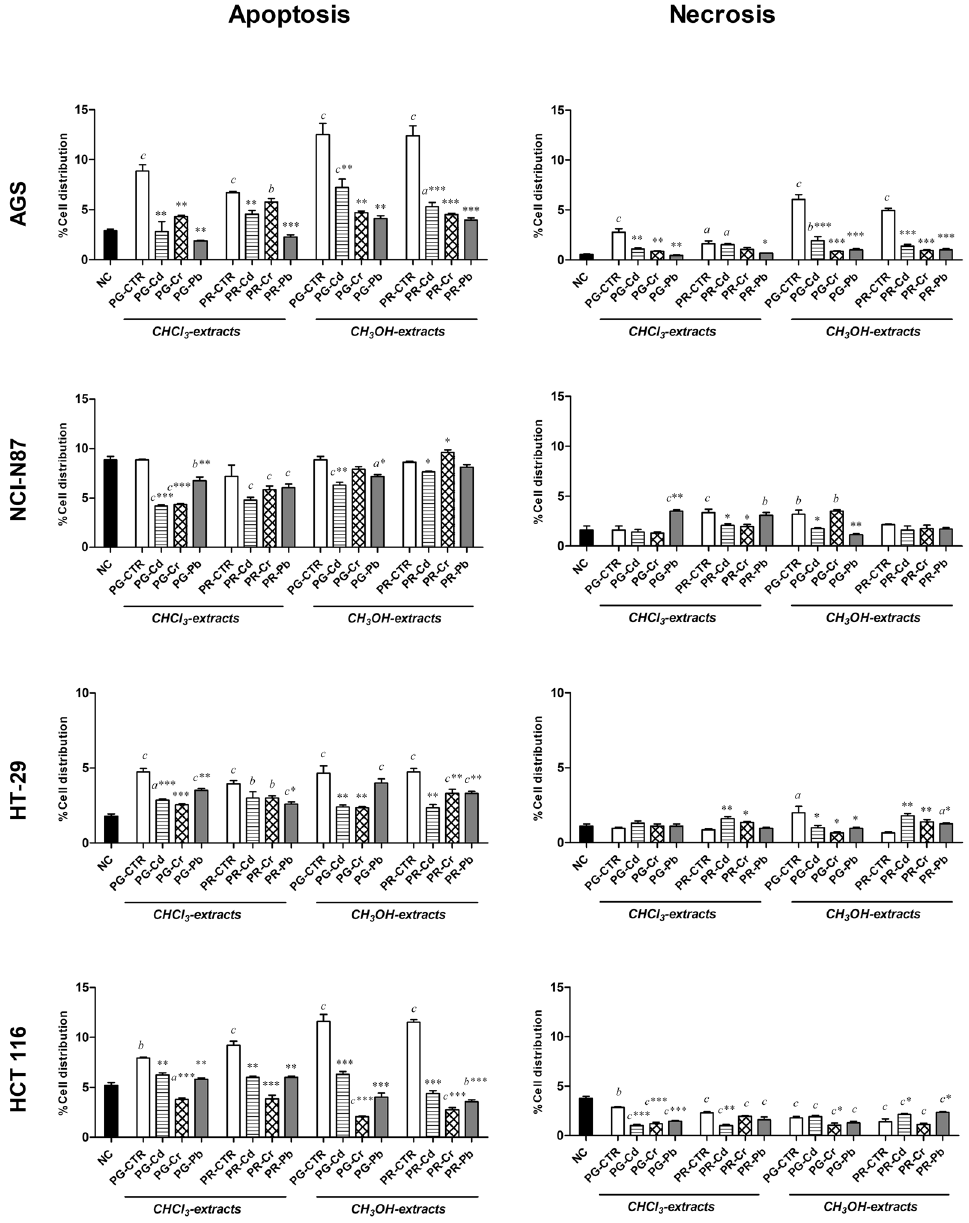
Figure 4. Histograms of apoptotic and necrotic AGS, NCI-N87, HT-29 and HCT 116 cell distribution (in percent) after 72-h treatment. Histograms of apoptotic and necrotic AGS, NCI-N87, HT-29 and HCT 116 cell distribution (in percent) after 72-h treatment with IC50 of chloroform and methanol extracts of Pomodoro Giallo (PG) and San Marzano Cirio 3 (PR) fruits, grown with or without heavy metals (Cd, Cr, Pb) contamination. Results are expressed as means ± SD of three separate experiments. Significant differences from the negative control (NC, untreated cells) are highlighted by letters ( a : p < 0.05; b : p < 0.01; c : p < 0.0001— Dunnett’s test). Significant differences between uncontaminated and contaminated tomato extracts are highlighted by asterisks (* p < 0.05; ** p < 0.01; *** p < 0.0001—Dunnett’s test). The software used to generate this figure was GraphPad Prism